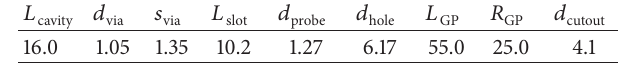
Table 2: Dimensions of the antenna